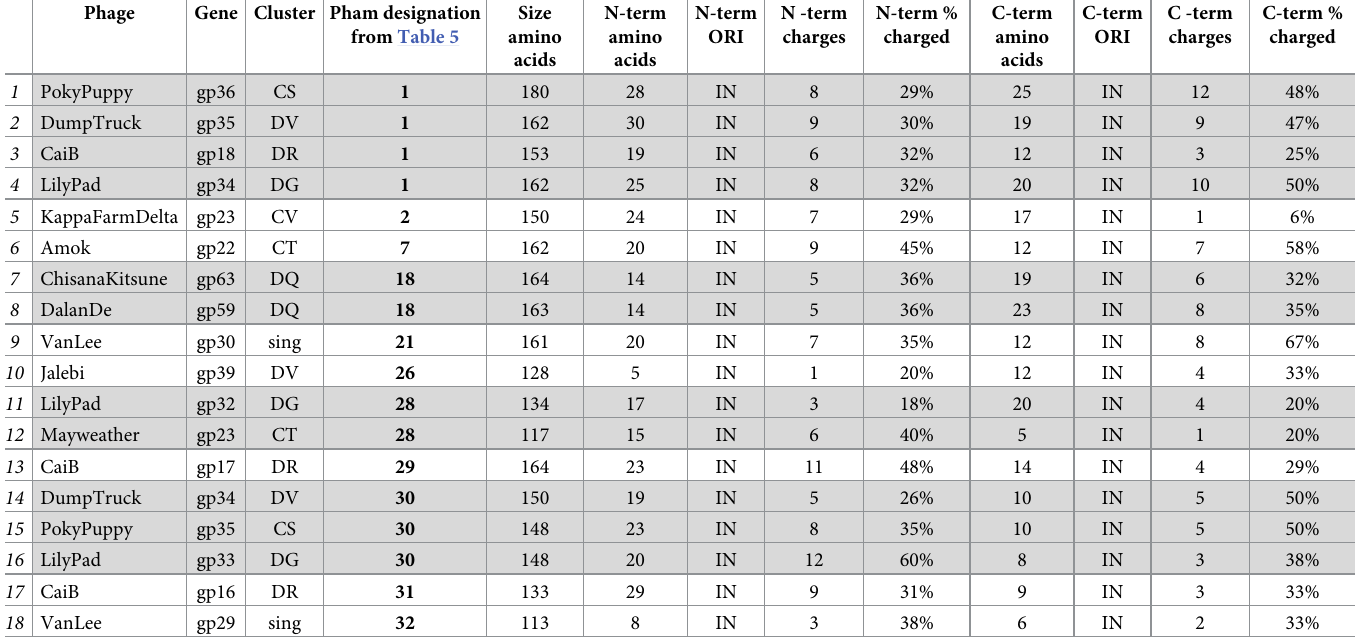
Table 8. Characterization proteins with 4 TM helices. Phage Gene Cluster Pham designation from Table